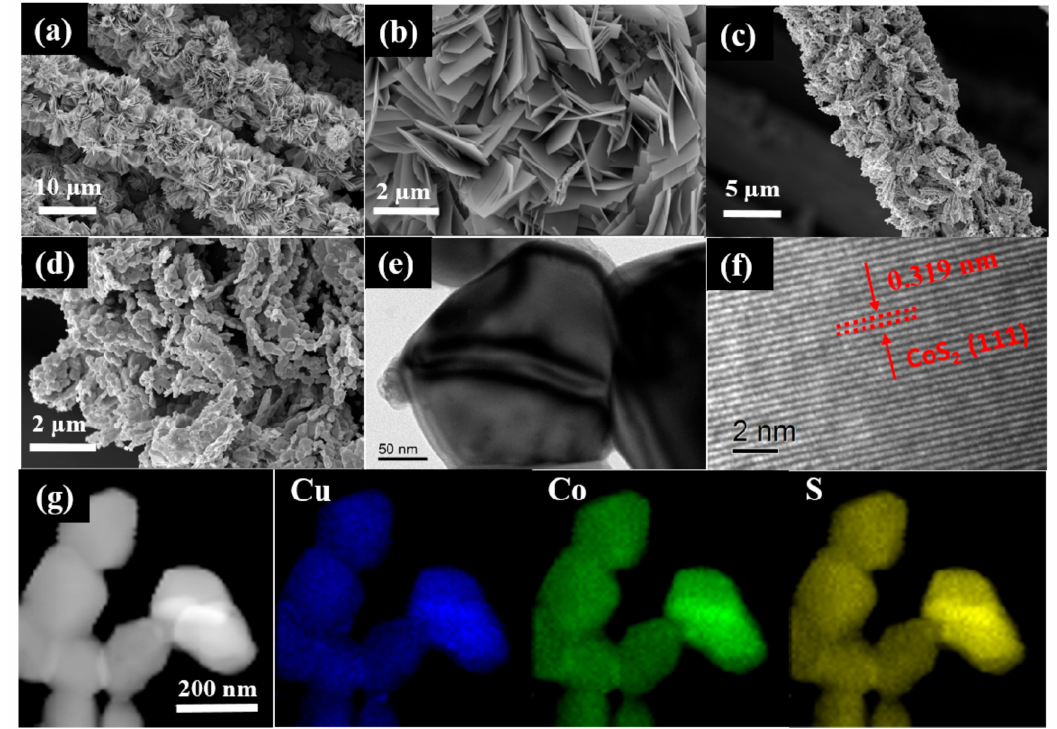
Figure 1. Scanning electron microscopy (SEM) image of ( a ) and ( b ) CuCo precursor / CC at di ff erent magnifications, ( c ) and ( d ) CuCoS / carbon cloth (CC) at di ff erent magnifications. ( e ) Transmission electron microscopy (TEM) and ( f ) high-resolution TEM images of CuCoS / CC. ( g ) TEM image and the corresponding Cu, Co, S element mapping